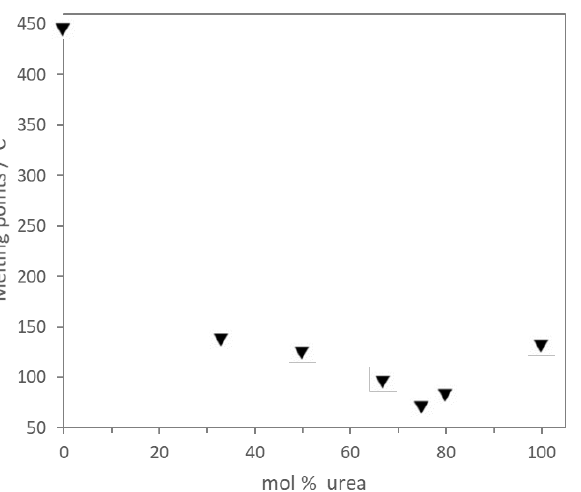
Figure 3. Dependence of DES ([urea-Zn]I 2 ) melting points on DES composition. Reprinted with permission from Ref. [46].